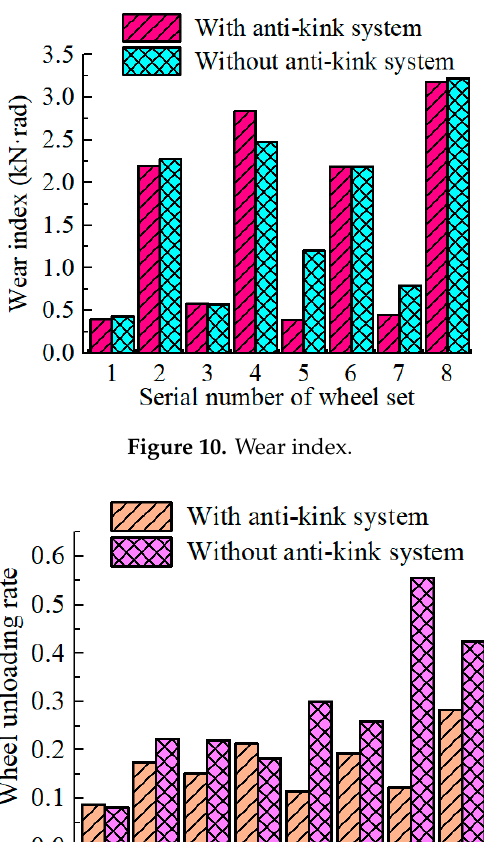
Figure 9. Derailment coefficient.